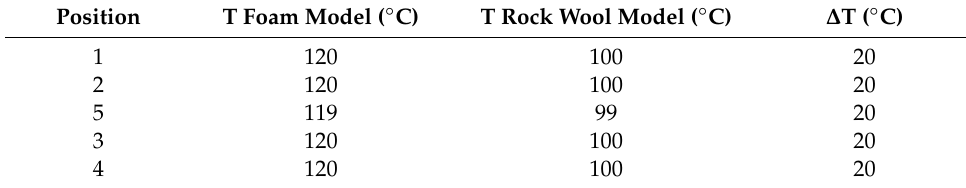
Table 4. Comparison between temperatures of the foam and rock-wool models.